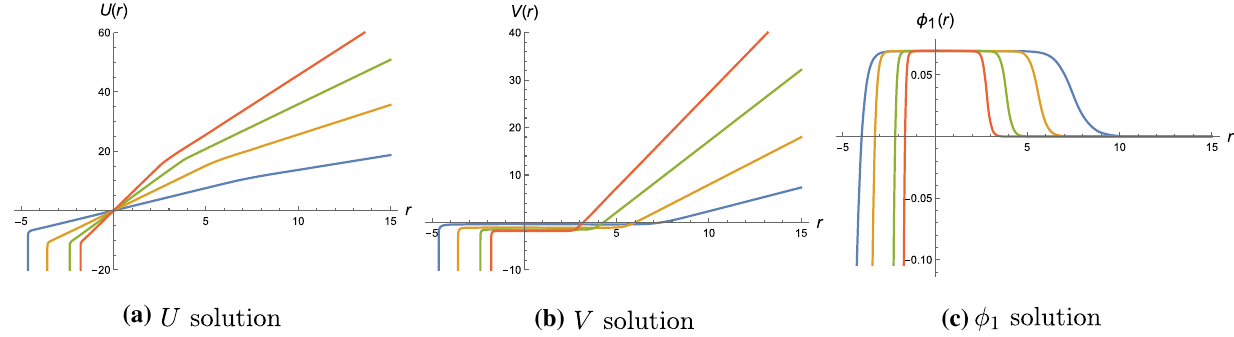
Fig. 8 RG flows from the N = 4 AdS 7 critical point to the AdS 4 × H 3 fixed point and curved domain walls for SO ( 3 ) twists with φ 1 → −∞ . The blue, orange, green and red curves refer to g = 8 , 16 , 24 , 32, respectively